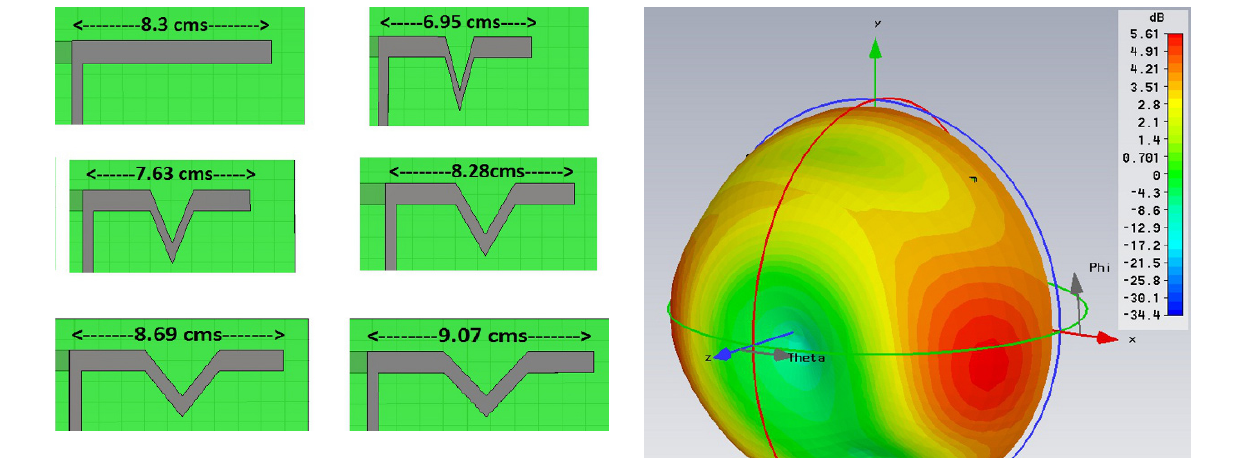
Figure 8. Dimensional difference due to difference in flare angle.